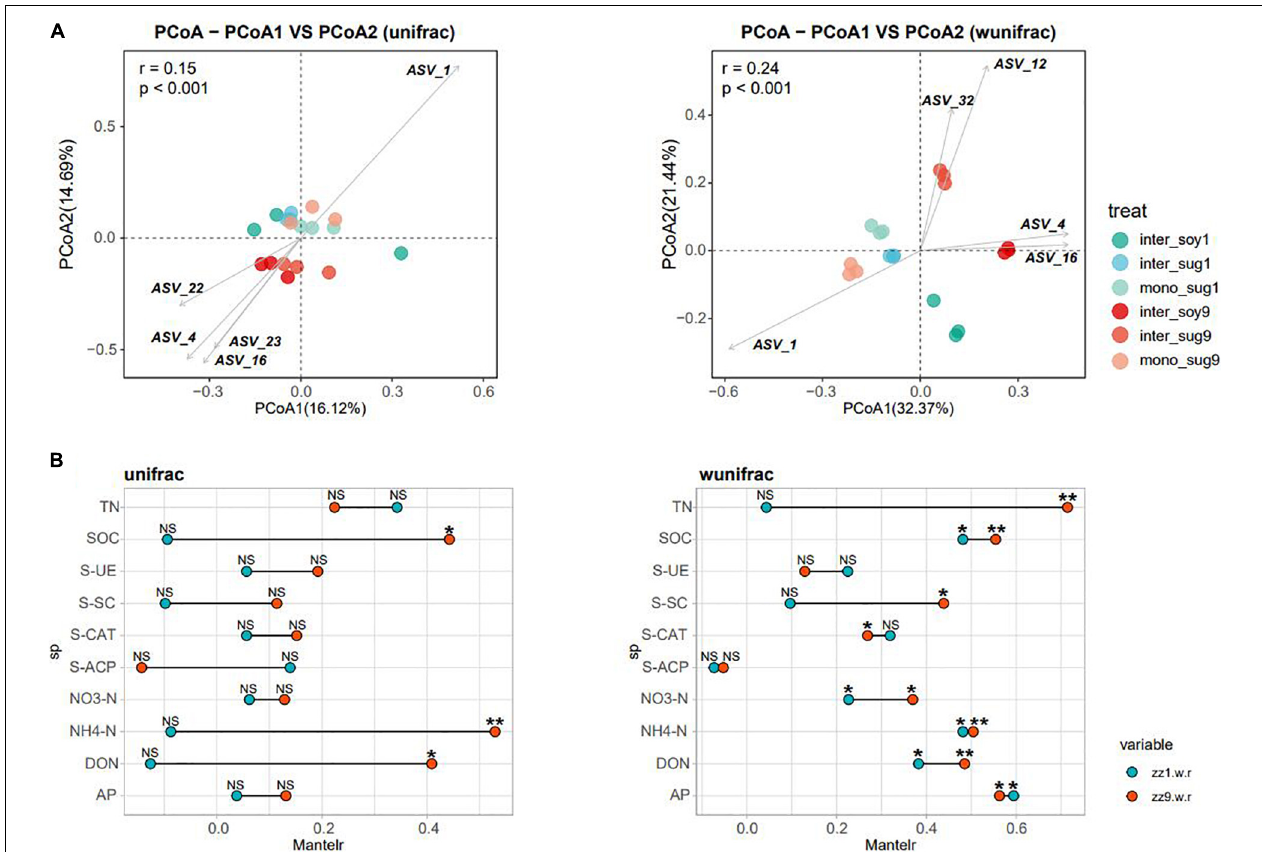
FIGURE 2 | (A) Principal coordinate analyses (PCoAs) using UniFrac distance matrix, to analyze the differences in the diversity of bacterial beta under different patterns, figure in left side is unweighted, figure in right side is weighted. (B) Mantel test was used to o compare the correlation difference of soil nutrients between ZZ1 and ZZ9, figure in left side is unweighted, and figure in right side is weighted. P > 0.05 (NS), P < 0.05(*), P < 0.01(**).